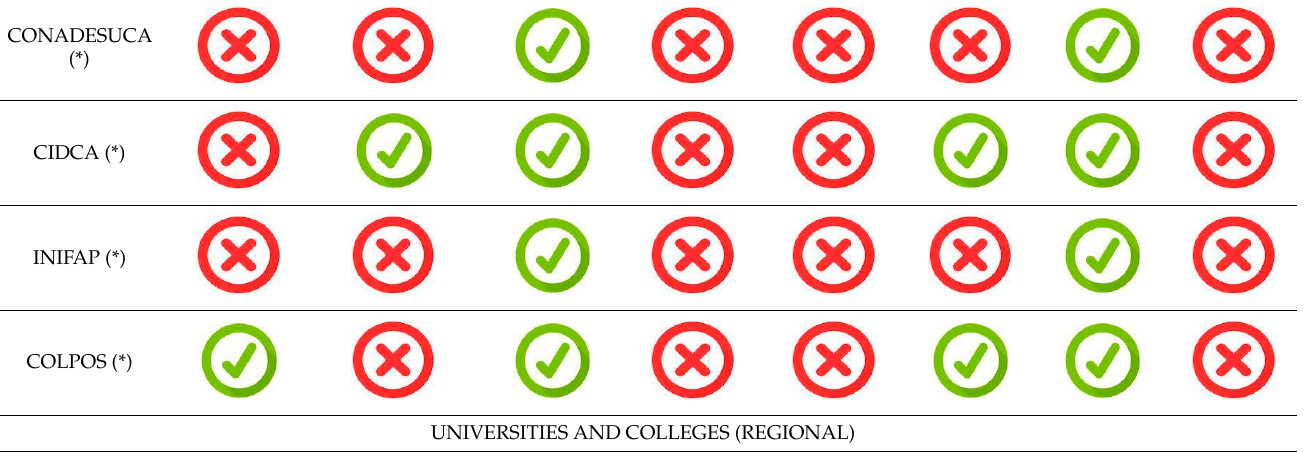
Table 3. Relations of R&D system with the conservative, intermediate and innovative network actors.